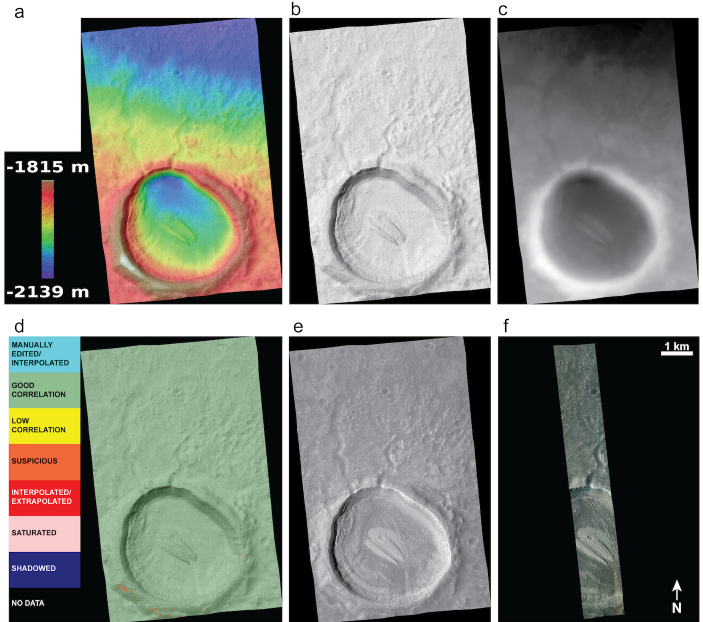
Figure 7. PDS “Extras”, or browse product examples for DTEEC_052299_2150_052510_2150. All images shown at same scale with north up, illumination from the upper left. ( a ) Colorized altimetry draped over shaded relief with legend from annotated version. ( b ) Shaded relief map. ( c ) Grayscale elevation. ( d ) FOM map, the only Extra made at full scale in JPEG2000 format with a detached legend. ( e ) Orthoimage of one half of the stereo pair, ESP_052299_2150. ( f ) Corresponding enhanced color (near–infrared, red and blue–green, IRB) orthoimage.